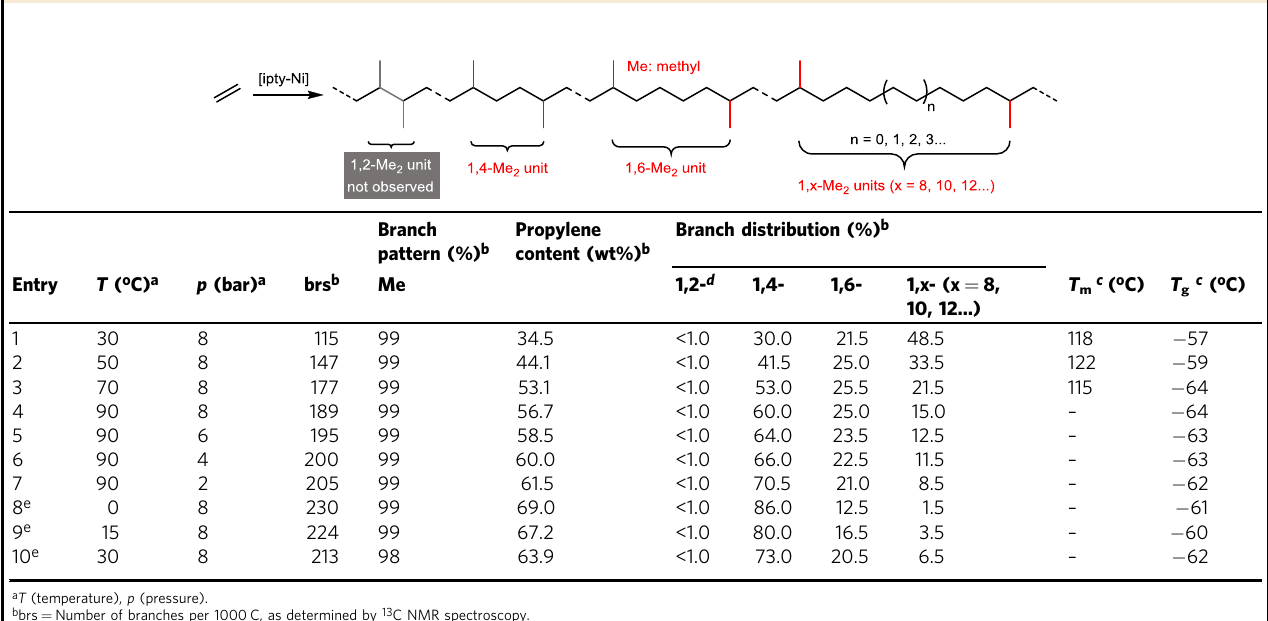
Table 2 Analysis of branch pattern and distribution.